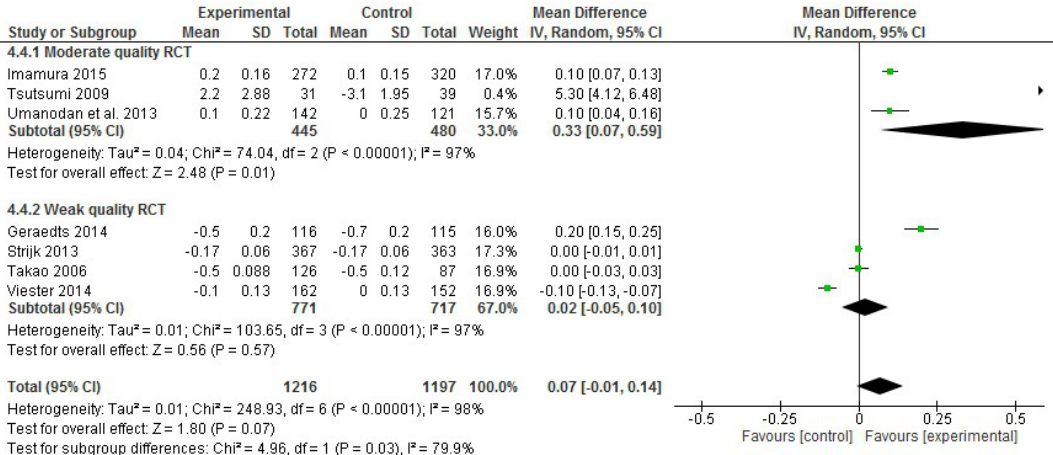
Figure 7. Forest plots of the e ff ectiveness of workplace interventions for improving employees’ productivity according to the quality of the studies.